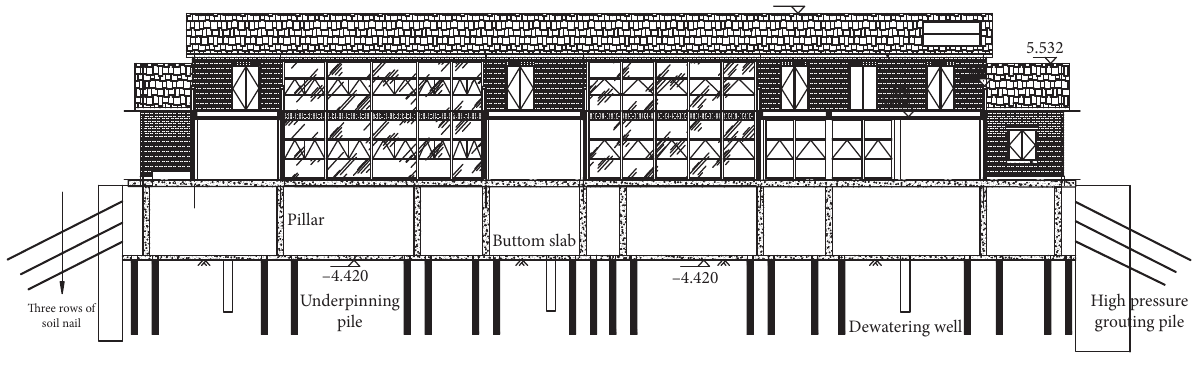
Figure 14: New basement